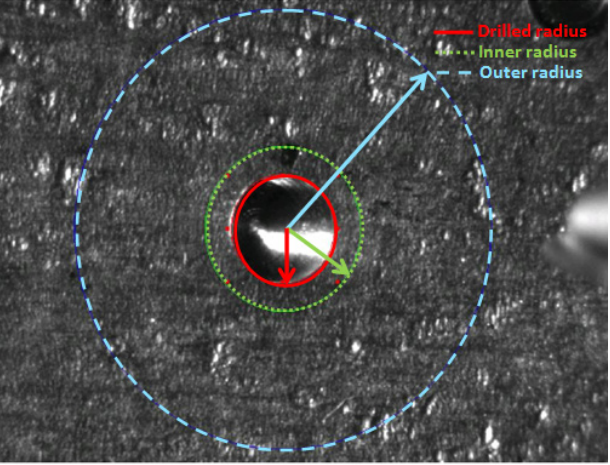
Figure 5: Screenshot of the area of analysis included between the outer circle (dashed line) and the inner circle (dotted line). The solid line identifies the drilled hole.